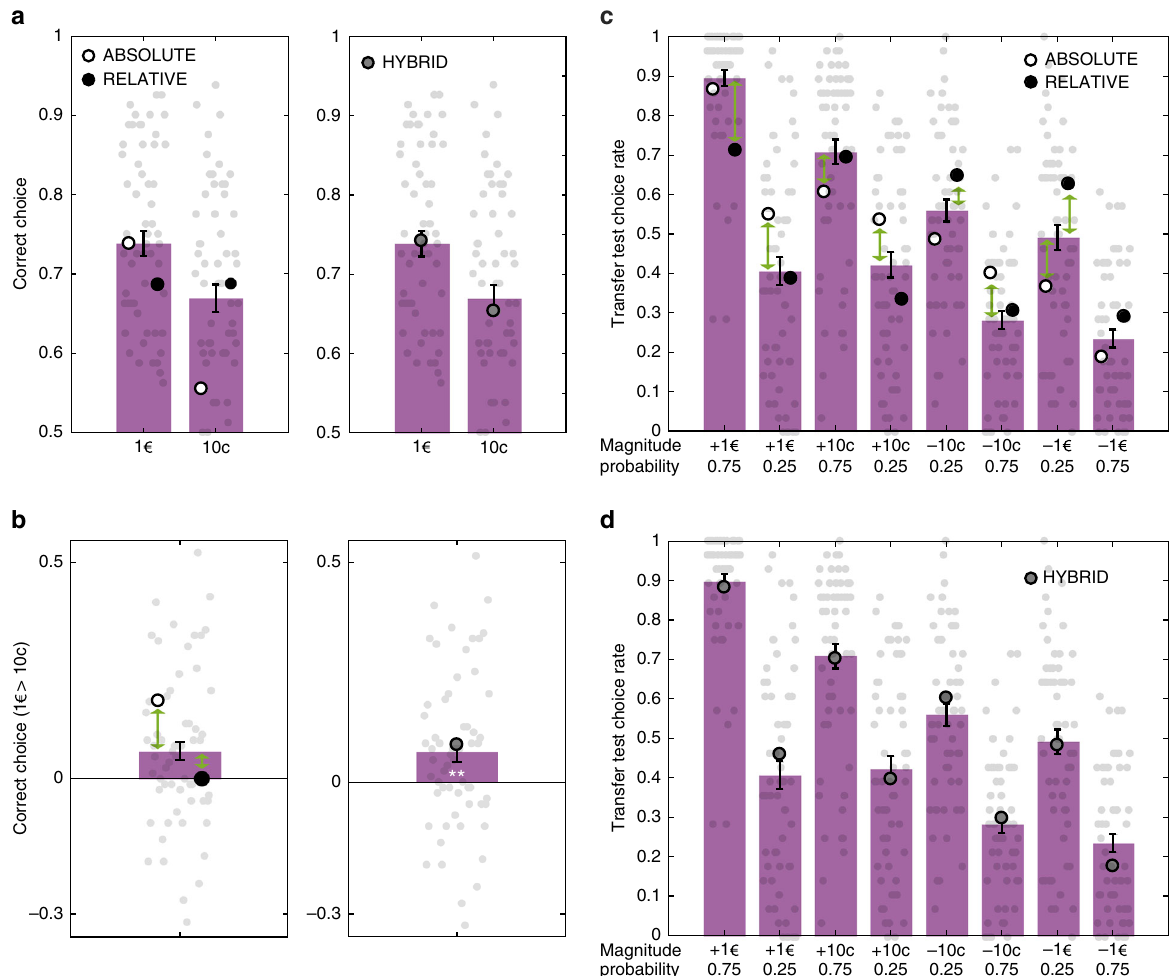
Fig. 2 Behavioral results and model simulations. a Correct choice rate during the learning sessions. b Big magnitude contexts ’ minus small magnitude contexts ’ correct choice rate during the learning sessions. c and d Choice rate in the transfer test. Colored bars represent the actual data. Big black (RELATIVE), white (ABSOLUTE), and gray (HYBRID) dots represent the model-predicted choice rate. Small light gray dots above and below the bars represent individual subjects ( N = 60). White stars indicate signi fi cant difference compared to zero. Error bars represent s.e.m. ** P < 0.01, t -test. Green arrows indicate signi fi cant differences between actual and predicted choices at P < 0.001, t